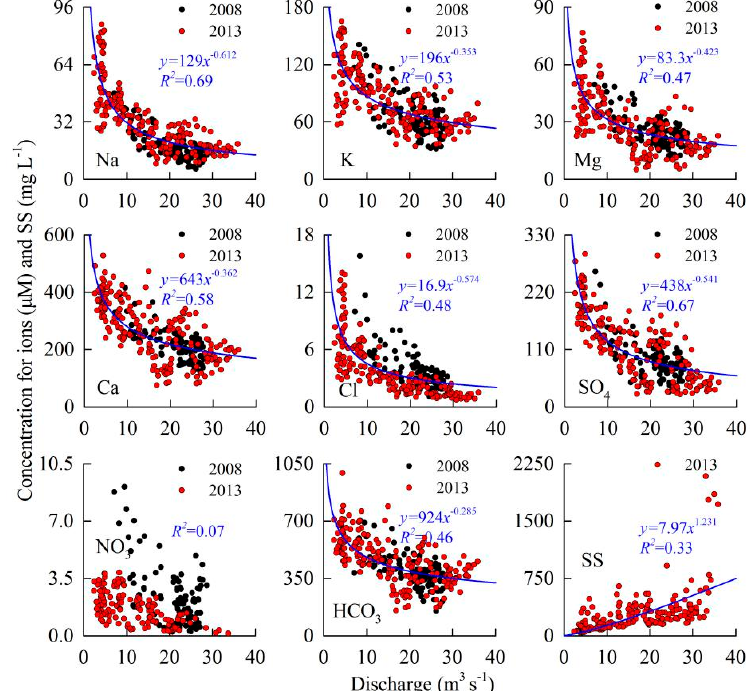
Figure 4. Relationships between river discharge and concentrations of major ions and suspended sediments (SS) in river water at the Hailuogou basin over two melt seasons in 2008 and 2013. Daily fluxes of most ions and SS also exhibited a strong seasonality, with higher values during high flow season and lower values during low flow seasons (Figure 5). Daily fluxes were positively related to river discharge ( r > 0.48 and p < 0.01 for ions, and r = 0.69 and p < 0.01 for sediments),